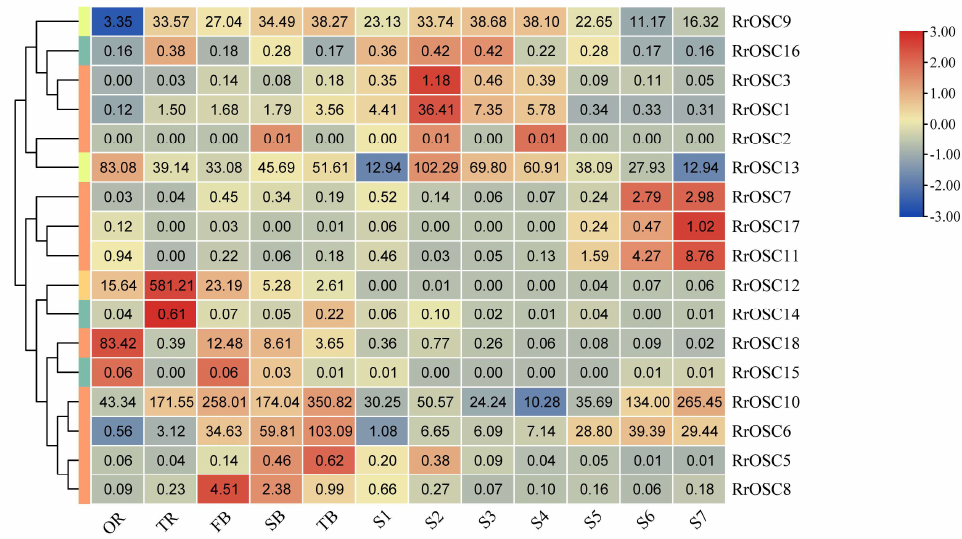
Figure 4. Digital gene expression profiles in the roots, lateral branches, and flowers of R. rugosa “Zi Zhi”. A heat map was generated based on the normalized Log2 FPKM represented by the blue- yellow gradation. The numbers in the heat map were FPKM from RNA-seq data. The OR and TR columns represent the roots of open-air and tissue culture seedlings, respectively The columns of FB, SB, and TB represent the primary, secondary, and tertiary lateral branches, respectively. The columns of S1–S7 represent the seven flower stages, respectively.